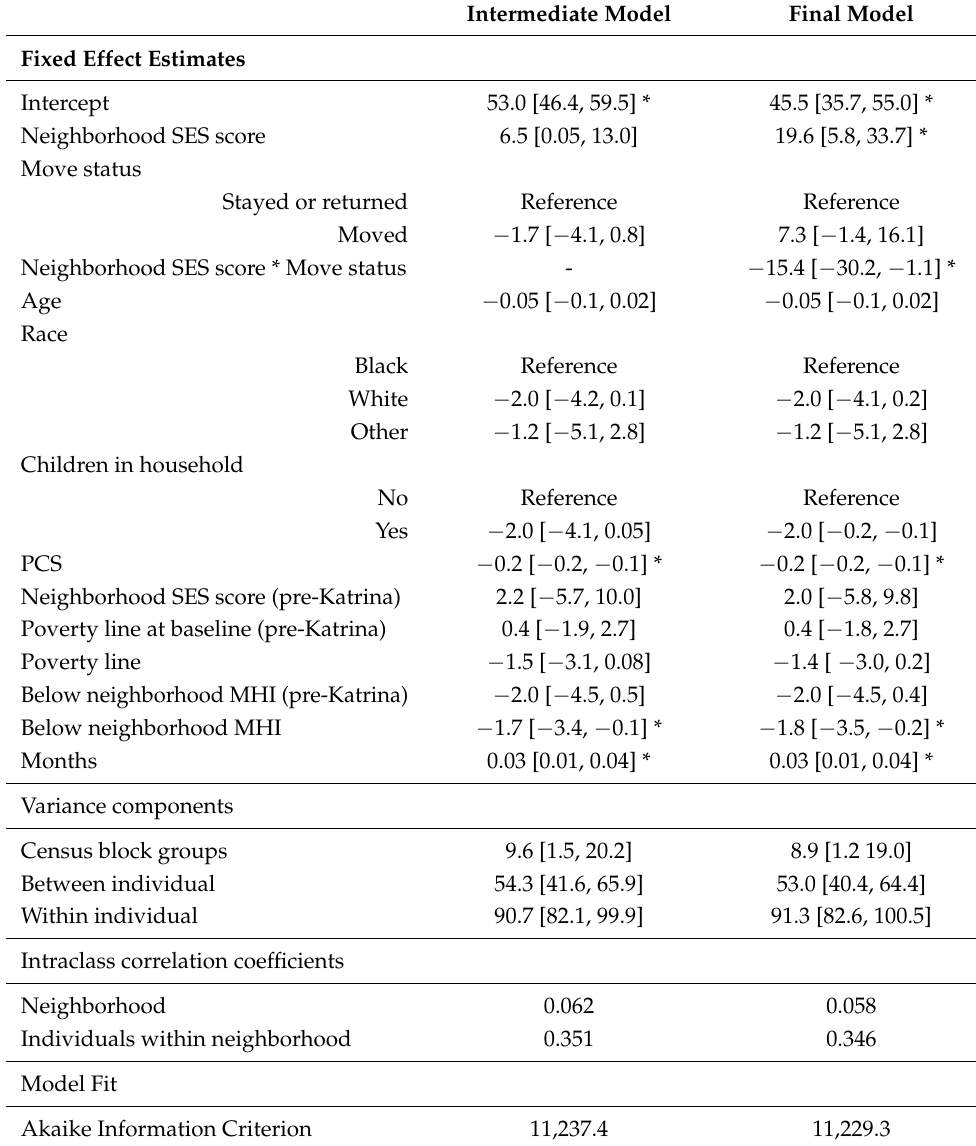
Table 3. Nested models describing the associations between neighborhood socioeconomic status and MCS score after Hurricane Katrina among GCAFH study